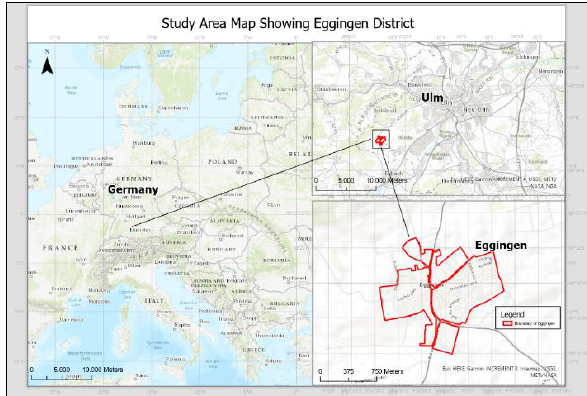
Figure 1 : Study Area